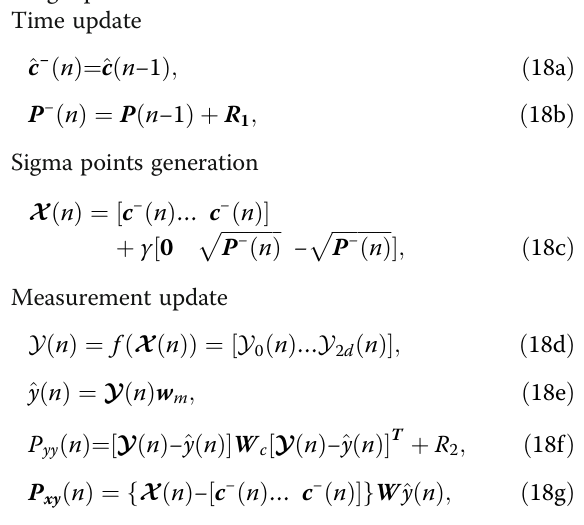
ffiffiffiffiffiffiffiffiffiffiffiffi P − ð n Þ